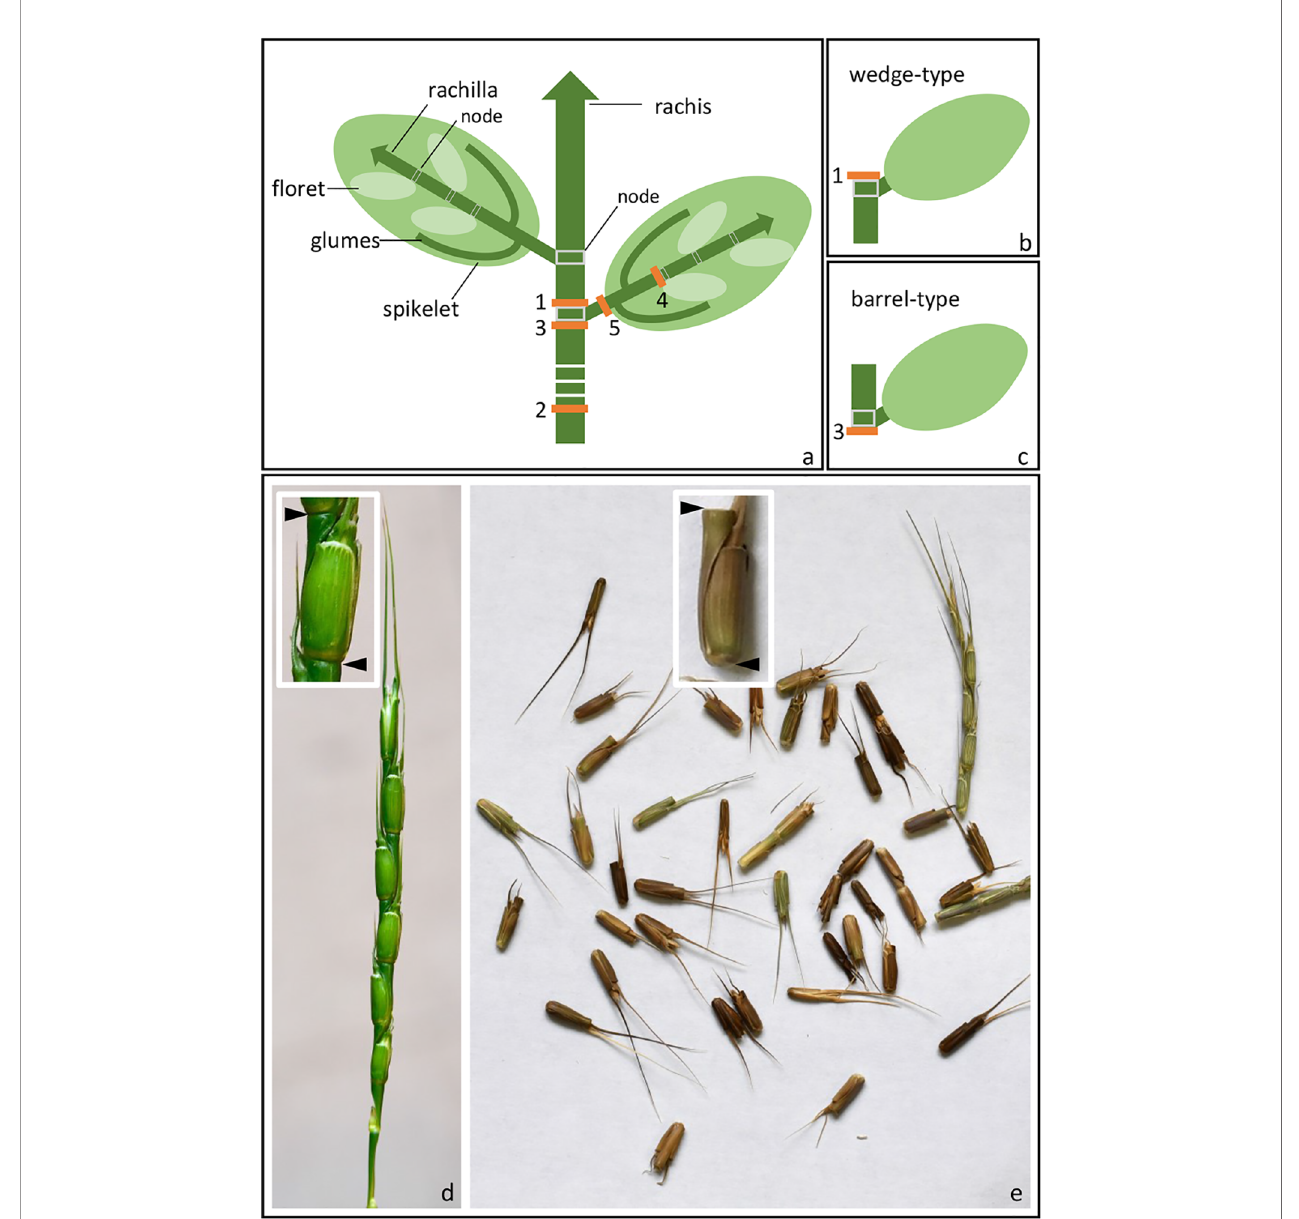
FIGURE 1 | Spike disarticulation in Triticeae species. (A) In the mature spike, disarticulation can occur either (1) above the rachis nodes, (2) above the lowest rachis node, (3) below the rachis nodes, (4) below the rachilla nodes, or (5) below the glumes. (B) Disarticulation above the rachis node produces a wedge-type dispersal unit, while (C) disarticulation below the rachis node produces a barrel-type dispersal unit. (D, E) Barrel-type brittle rachis generated from Ae. tauschii (accession: AL8/78). Spike before (D) and upon (E) maturity was shown. Arrows indicate the disarticulation